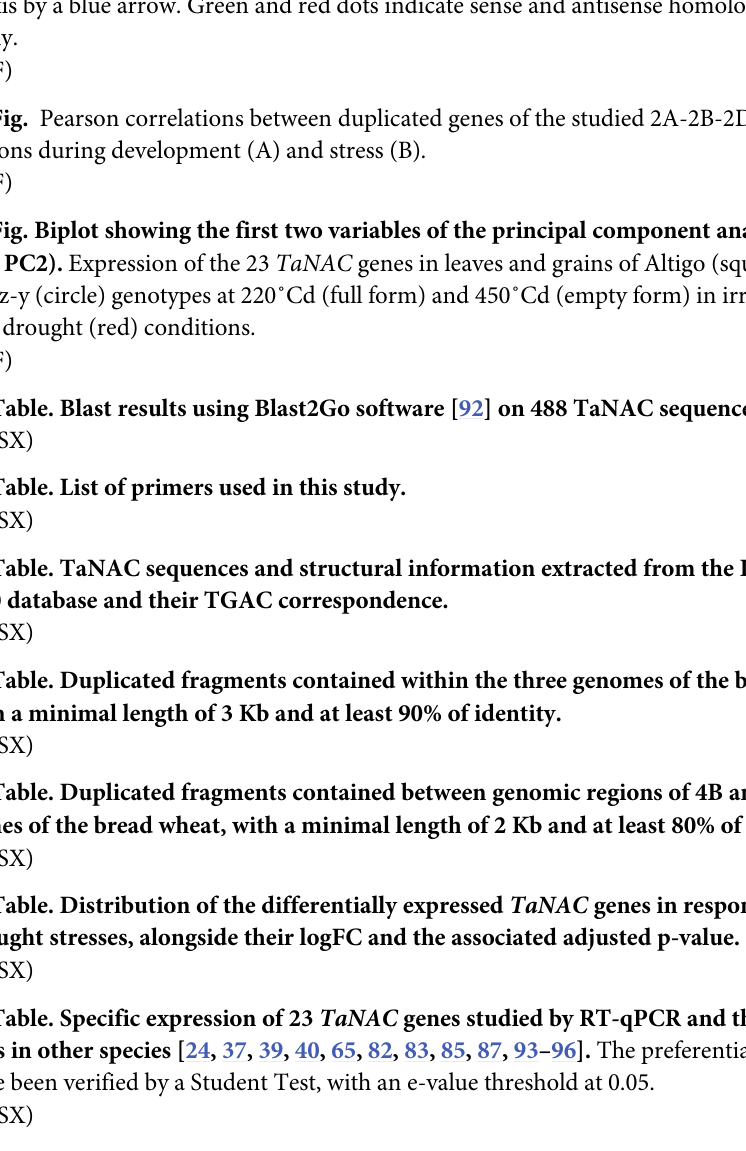
S4 Fig. Structural conservation between the two regions of chromosomes 4B and 5A geno- mics sequences, revealed by dot plot analysis. Each gene location is indicated on the x- and y-axis by a blue arrow. Green and red dots indicate sense and antisense homologies respec- tively. S5 Fig. Pearson correlations between duplicated genes of the studied 2A-2B-2D chromosomal regions during development (A) and stress (B). S6 Fig. Biplot showing the first two variables of the principal component analysis (PC1 and PC2). Expression of the 23 TaNAC genes in leaves and grains of Altigo (square) and Allez-y (circle) genotypes at 220˚Cd (full form) and 450˚Cd (empty form) in irrigated (blue) and drought (red) conditions. S1 Table. Blast results using Blast2Go software [92] on 488 TaNAC sequences. S2 Table. List of primers used in this study. S3 Table. TaNAC sequences and structural information extracted from the IWGS RefSeq v1.0 database and their TGAC correspondence. S4 Table. Duplicated fragments contained within the three genomes of the bread wheat, with a minimal length of 3 Kb and at least 90% of identity. S5 Table. Duplicated fragments contained between genomic regions of 4B and 5A chromo- somes of the bread wheat, with a minimal length of 2 Kb and at least 80% of identity. S6 Table. Distribution of the differentially expressed TaNAC genes in response to heat and drought stresses, alongside their logFC and the associated adjusted p-value. S7 Table. Specific expression of 23 TaNAC genes studied by RT-qPCR and their ortholo- gues in other species [24, 37, 39, 40, 65, 82, 83, 85, 87, 93–96]. The preferential expression have been verified by a Student Test, with an e-value threshold at